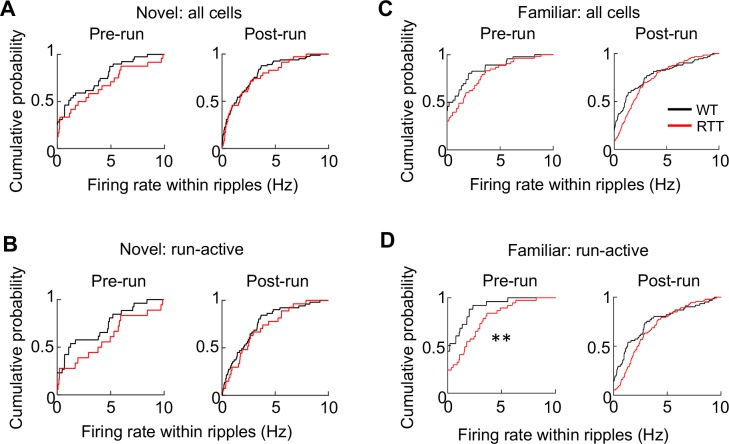
Firing rates of CA1 cells in WT and RTT mice within ripples.(A) Cumulative distributions of firing rate for all putative CA1 pyramidal cells within ripple events before (Pre-run) and after (Post-run) running on the novel track. Pre-run: N = 40 (WT), 26 (RTT); p=0.14, Wilcoxon ranksum test. Post-run: N = 84 (WT), 39 (RTT); p=0.35. (B) Same as in (C), but for run-active cells. Pre-run: N = 26 (WT), 20 (RTT); p=0.07. Post-run: N = 53 (WT), 31 (RTT); p=0.23. (C, D) Same as in (A, B), respectively, but before and after running on the familiar track. (C) Pre-run: N = 51 (WT), 50 (RTT); p=0.06; Post-run: N = 102 (WT), 135 (RTT); p=0.11. (D) Pre-run: N = 24 (WT), 42 (RTT); **p=0.003. Post-run: N = 65 (WT), 103 (RTT); p=0.06.